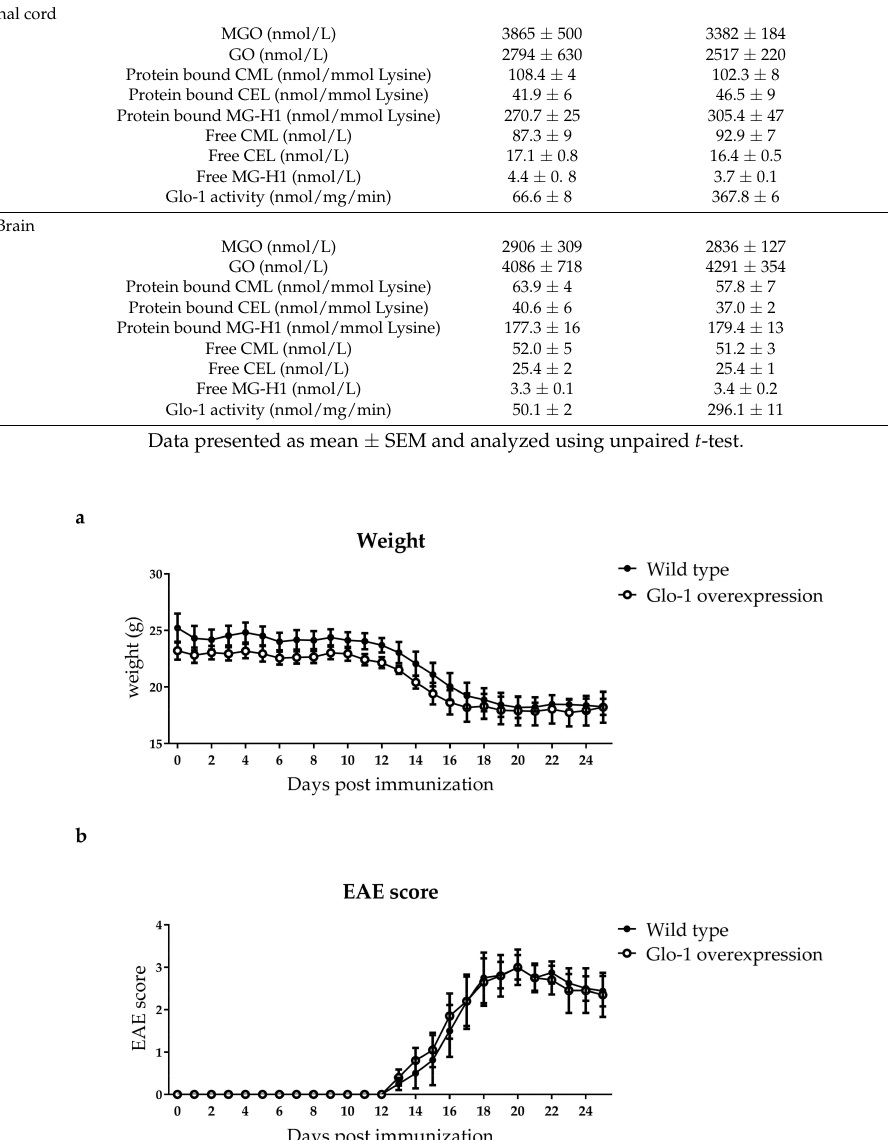
) represent Glo-1 overexpression (cid:35)